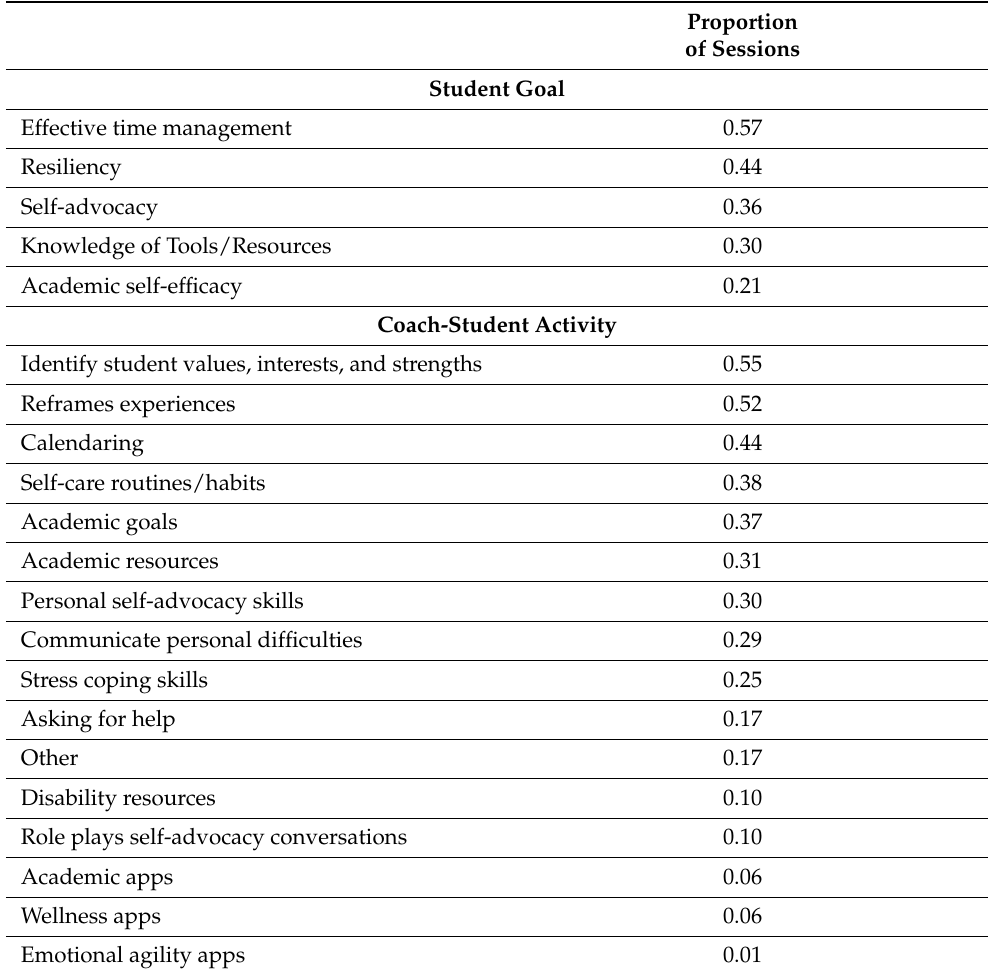
Table 2. Proportion of sessions in which specific goals for sessions were identified and specific PASS coach activities occurred for 10 coaches reporting on 89